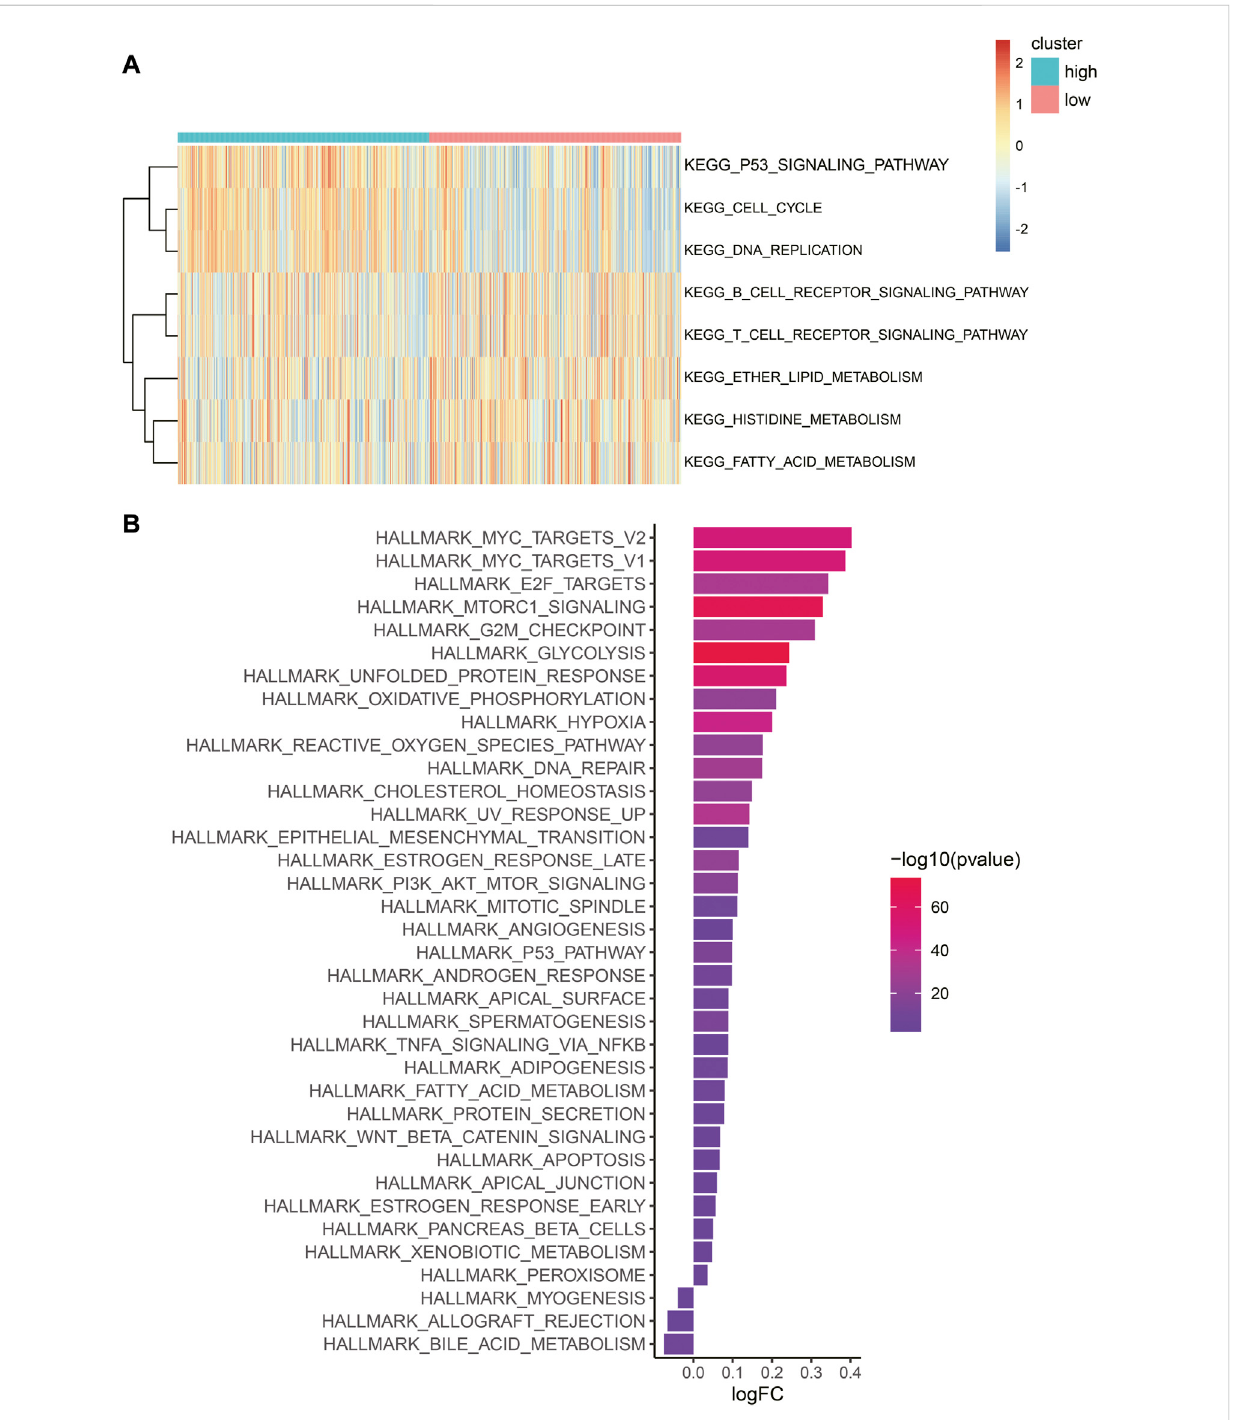
FIGURE 7 Difference in biological pathways and cancer-related gene sets between the two risk categories. (A) Heatmap of GSVA enrichment of the KEGG pathway.Redrepresentshighenrichmentscores,whilebluerepresentslowenrichmentscores. (B) Bargraphofhallmarkgenesetenrichmentscore.The colorindicatesthesigni fi canceofthedifference,andthex-axisrepresentstheenrichmentscorefoldchangeinthishallmarkgenesetbetweenhigh-and low-risk